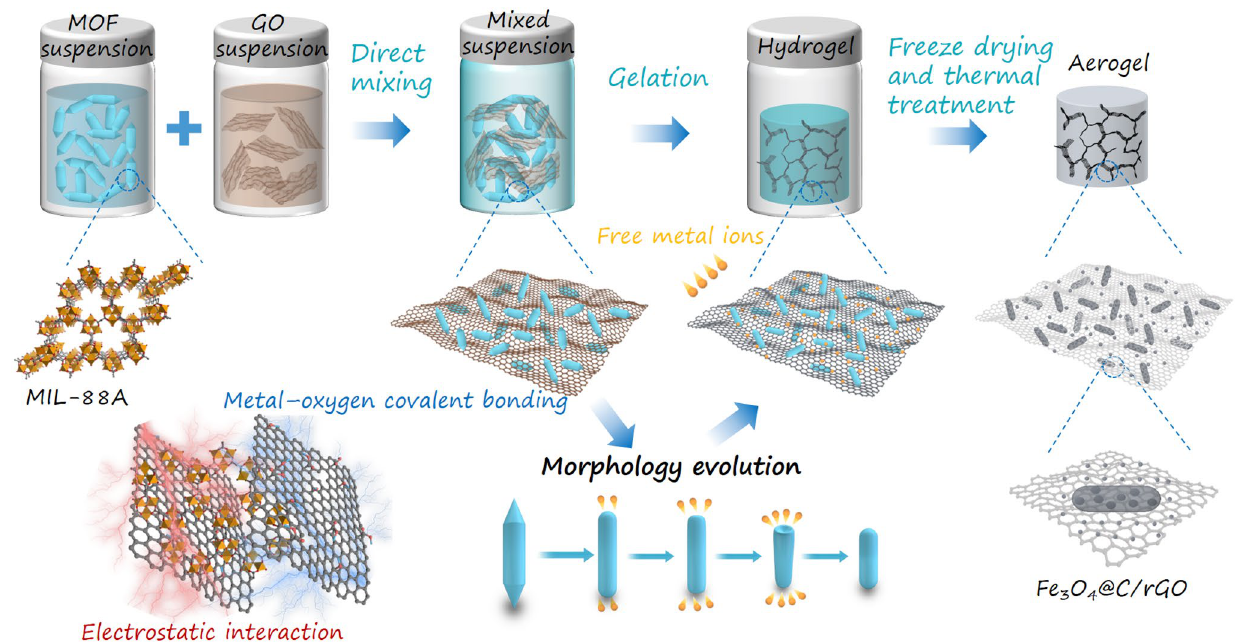
Fig. 1 Schematic of the fabrication process of MOF/rGO hybrid aerogels by the use of MOFs to directly initiate the gelation of GO